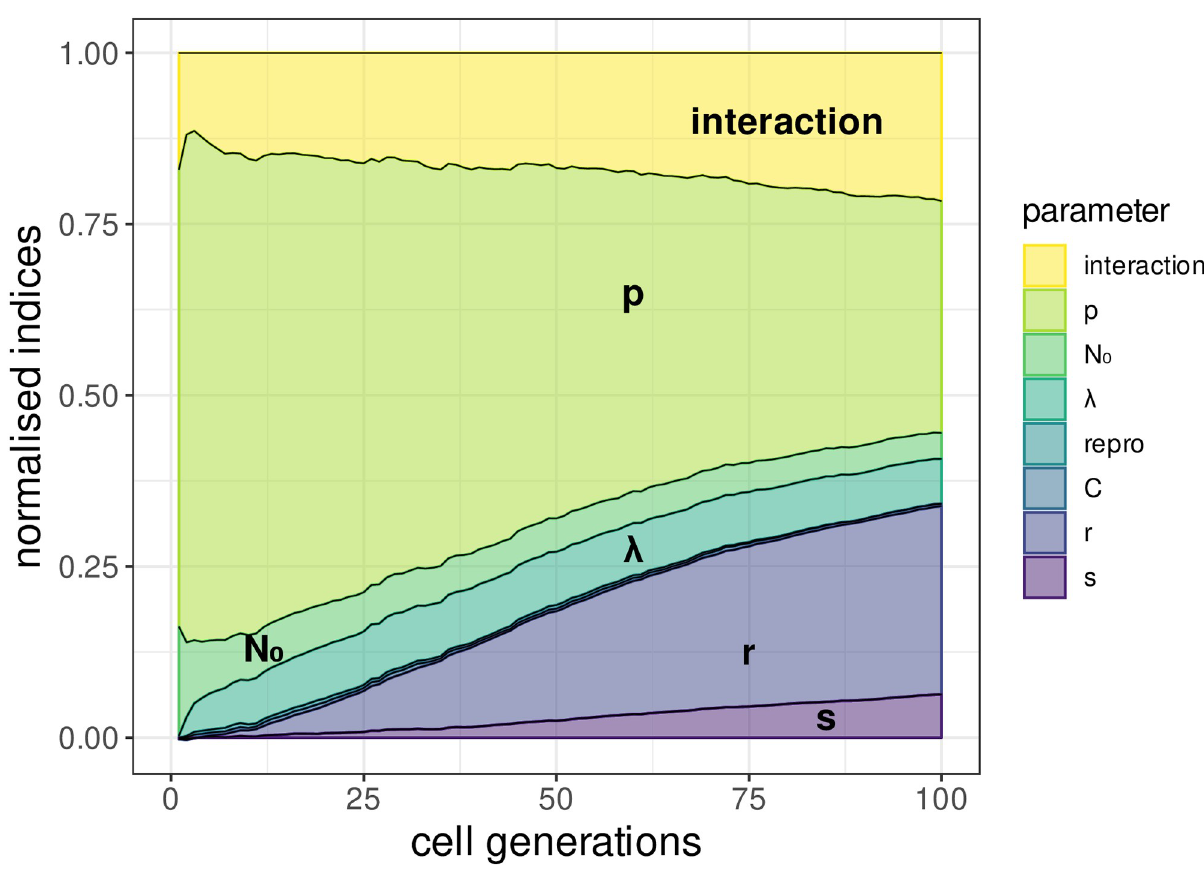
Fig 3. Variance-based sensitivity analysis for the cumulative probability of extinction ( p ext ). The normalized stacked first-order sensitivity indices ( Var = Var , with Var the total variance of p ext ) are displayed for all time steps and all parameters. The intracellular aspect dominates early in the i p ext p ext infection. The importance of inter-cellular aspect increases over time, mostly through the probability of symmetric divisions in two differentiated cells. Intracellular viral capacity C and type of reproduction (e.g. Dirac or Poisson distributed) are barely visible due to their small effect on the variability of the